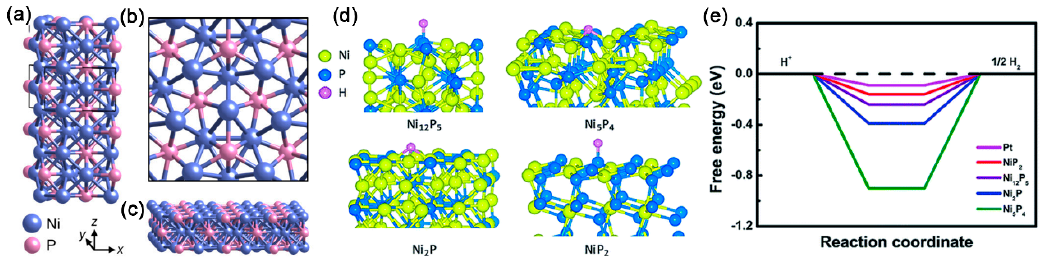
Figure 2. Crystal structure of Ni 2 P: four-unit cells stacked on top of one another, with a single unit cell outlined ( a ), top view of the Ni 2 P (001) surface ( b ), and a two-dimensional slice of Ni 2 P, showing the (001) surface on top ( c ). Reproduced with permission from Reference [45] the American Chemical Society, 2015. Optimized surface structures for the (001) faceted Ni 4 P 5 -terminated Ni 12 P 5 , Ni 3 P 2 -terminated Ni 2 P, Ni 4 P 3 -terminated Ni 5 P 4 , and P-terminated NiP 2 ( d ) and corresponding free energy profiles for Pt, Ni 12 P5, Ni 2 P, Ni 5 P 4 , and NiP 2 ( e ). Reproduced with permission from Reference [51]. The Royal Society of Chemistry, 2019.